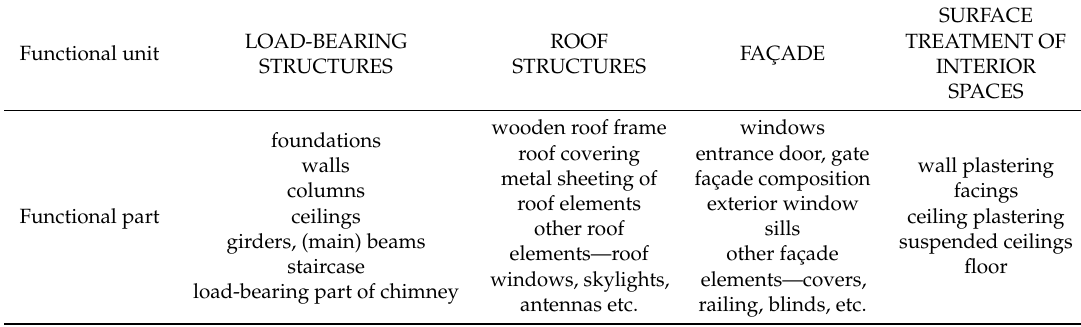
Table 1. Proposed connecting database with division to functional units and functional parts